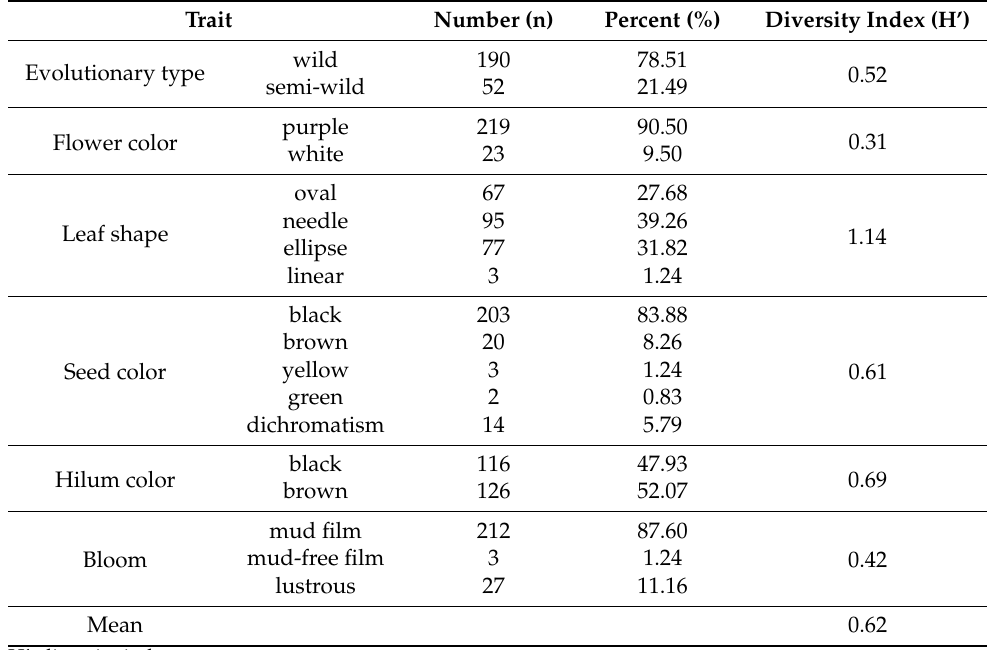
Table 2. Summary of six qualitative traits of 242 wild soybean samples in this study.